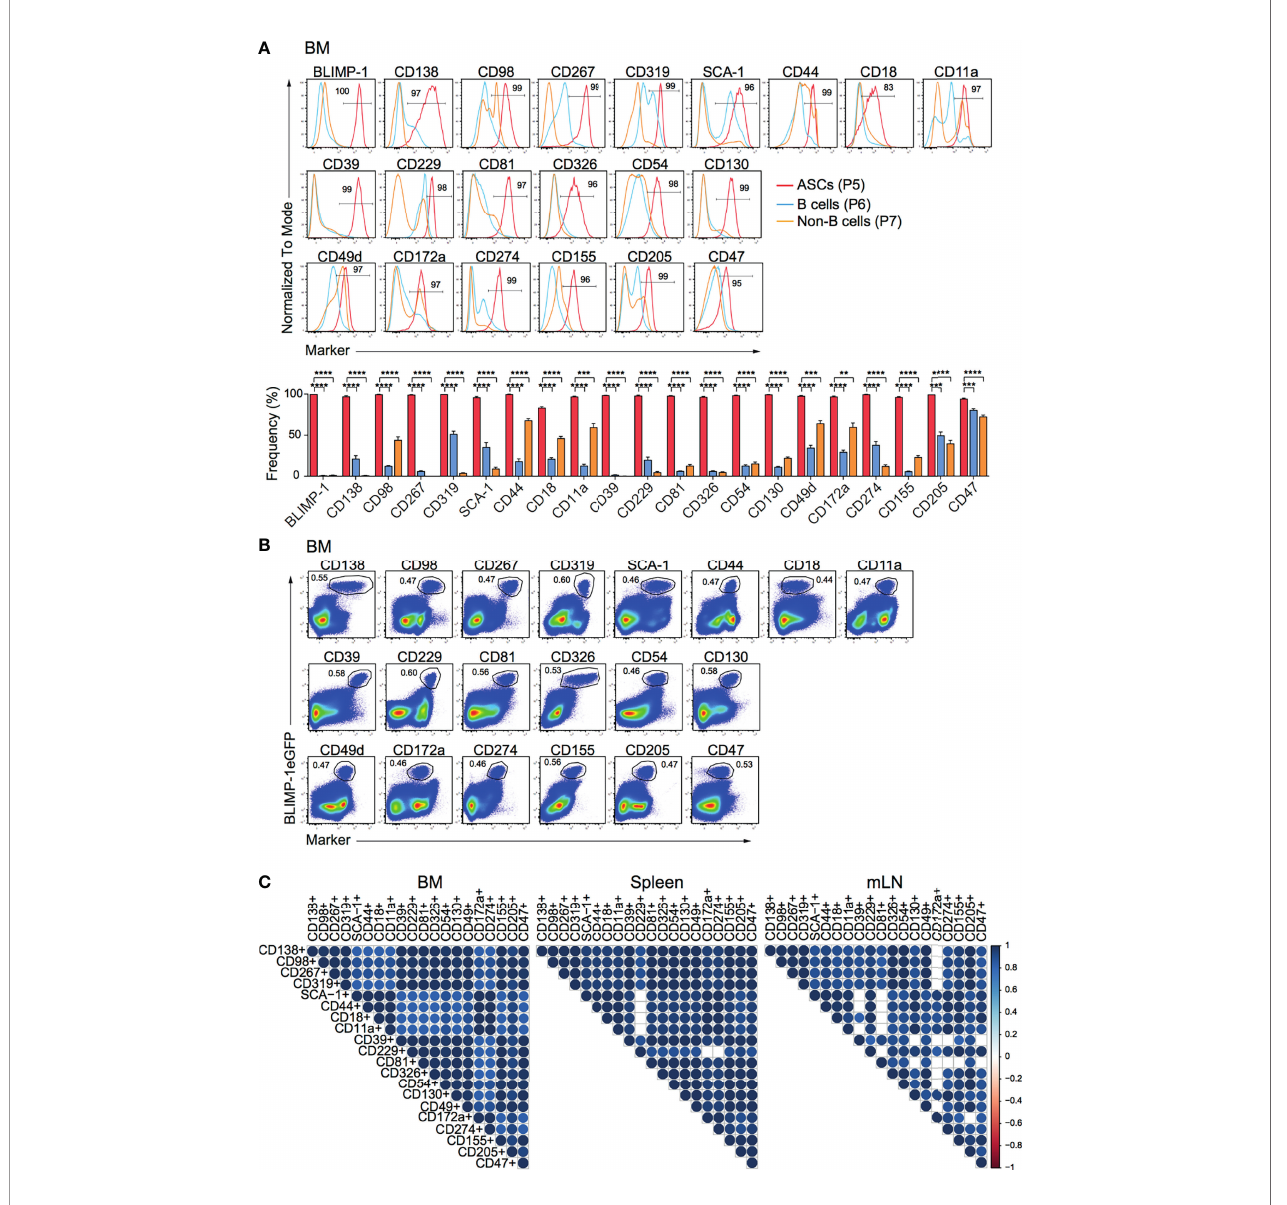
FIGURE 1 | ASCs in naive mice express CD39, CD229, CD81, CD326, CD54, CD130, CD49d, CD172a, CD274, CD155, CD205, and CD47. Analyses were performed with naive prdm1 eGFP mice. (A) Representative histograms (top, frequencies of ASCs are indicated) and frequencies (bottom) showing surface expression level of indicated markers by BM CD138 + BLIMP-1eGFP + ASCs, CD19 + CD138 - BLIMP-1eGFP - B cells and CD19 - CD138 - BLIMP-1eGFP - cells. Populations were gated as indicated in Supplementary Figure 1A . Groups were compared using two-way ANOVA with the Geisser-Greenhouse correction followed by Dunnett ’ s multiple comparisons test. Data represent mean ± SEM ( ∗∗ p < 0.01, ∗∗∗ p < 0.001, ∗∗∗∗ p < 0.0001). (B) Representative FACS plots demonstrating the co-expression of BLIMP-1eGFP with indicated markers in BM (populations were gated on live cells). (C) Spearman correlation matrix of ASCs populations (frequencies) de fi ned by co-expression of BLIMP-1eGFP and the indicated marker as shown in Panel (B) (BM), Supplementary Figure 1D (spleen) and Supplementary Figure 1E (mLN). Blue color indicates positive correlation with color intensity and size of the circle representing correlation coef fi cients. Only correlations with p<0.05 are depicted. Data shown were derived from two independent experiments (n=6